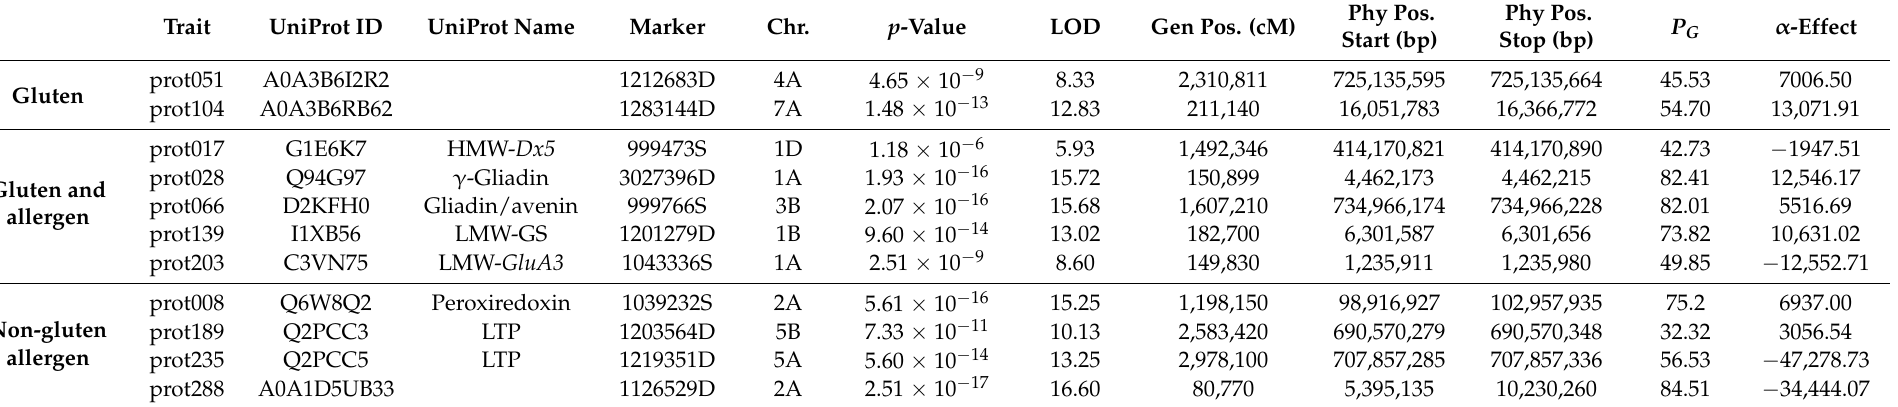
Table 1. QTLs controlling two gluten proteins, four non-gluten allergenic proteins and five gluten proteins, which were also listed as allergens in Allergome